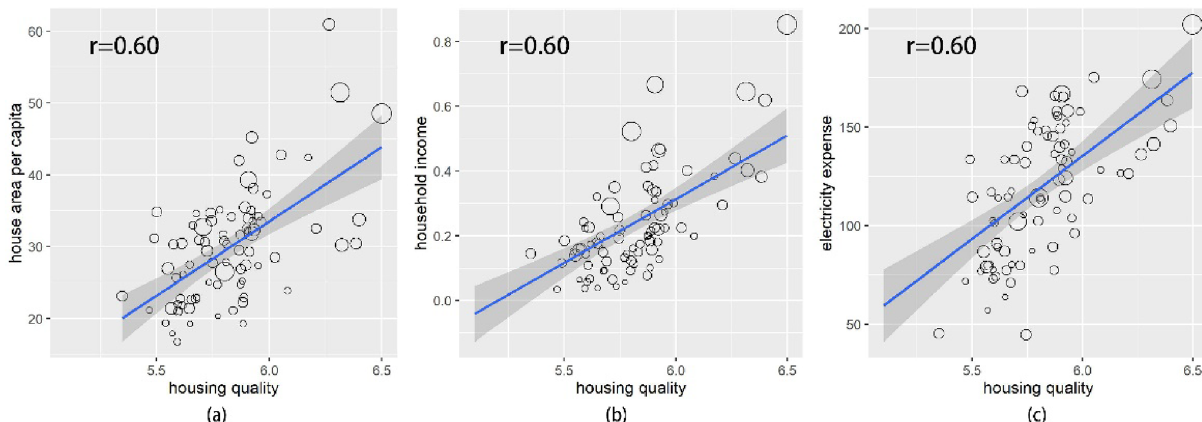
Figure 6. The relationship between housing quality and socio-economic indexes. Housing quality is the average predicted housing quality of one county. The dot size represents the disposal income per